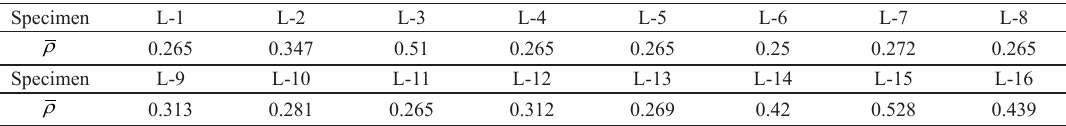
Table 3. Relative density of